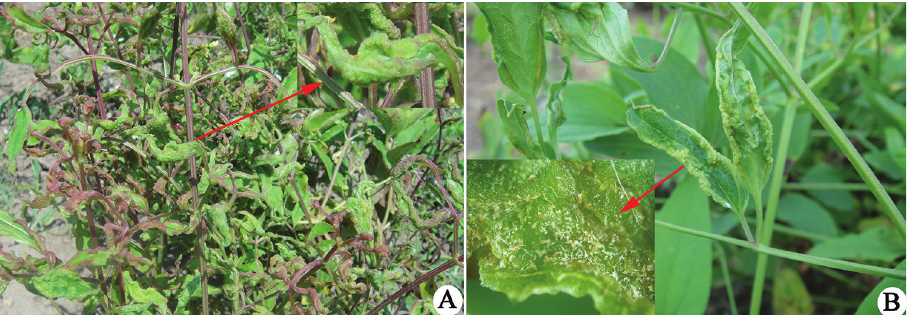
Figure 1. Damage symptoms associated with Aculops jilinensis sp. n. and Phyllocoptes terniflores sp. n. on Clematis terniflora var. mandshurica : A leaves have severely curled and blistered, red arrow indicates the magnified curled leaf B leaves have moderately curled and blistered, red arrow indicates part of the mite population hidden inside the curled